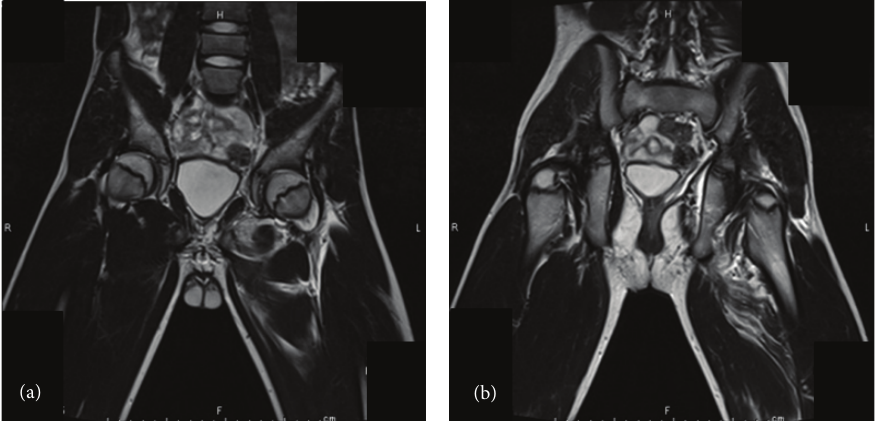
Figure 4: Coronal T2 weighted image in MRI shows no evidence of avascular necrosis of the femoral head (a) and damage of soft tissue (b) at 3 days.